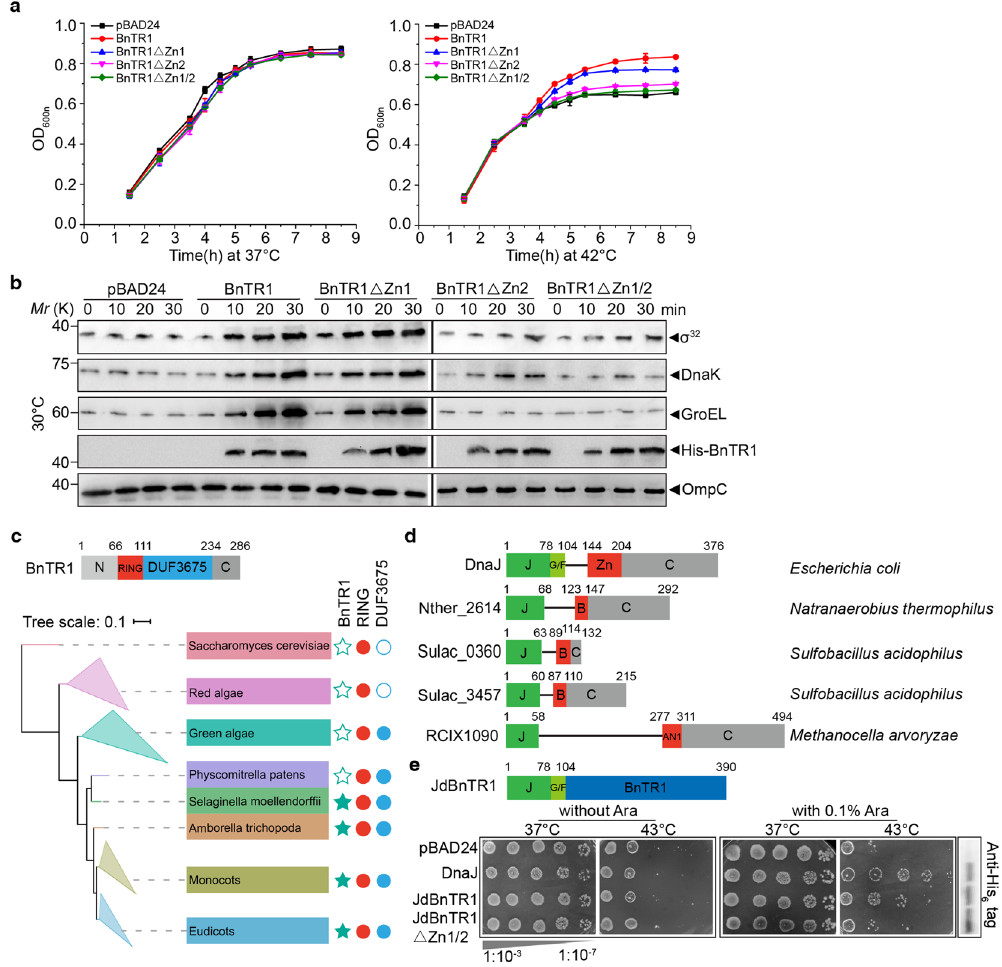
Figure 3. Two zinc fingers of BnTR1 have distinct functions. ( a ) Growth curves of E . coli C600 cells with BnTR1 mutants at 37 °C (left) and 42 °C (right). ( b ) Western blot with antibodies against His-BnTR1 (His antibody), σ 32 and chaperones (DnaK and GroEL). Whole-cell extracts were obtained from wild-type E . coli C600 cells. OmpC was used a loading control. Samples between gels were from the same experiments and were processed in parallel. ( c ) Diagrams indicate the BnTR1 domain structure. A reconstructed phylogenetic tree of Plantae , in which clades with multiple species (red algae, green algae, monocots, and eudicots) are collapsed. The present and absent homologues of full-length BnTR1, RING domain, and DUF3675 domain are denoted with filled and empty shapes, respectively. Drawn to scale: amino-terminus (N), DUF3675 (unknown function domain closely associated with zinc finger) domain and carboxyl-terminus (C). ( d ) Domain structures of representative prokaryotic proteins containing both J-domains and zinc fingers. Drawn to scale: zinc finger (Zn), J (J-domain), G/F (glycine/phenylalanine-rich) and B (B-box). ( e ) Complementation of temperature sensitive E . coli stains expressing pBAD24 constructed DnaJ, chimeric BnTR1 and mutants at 43 °C. The data are presented as means ± s.d. of three independent experiments ( a ). Full-length blots are presented in Supplementary Figure